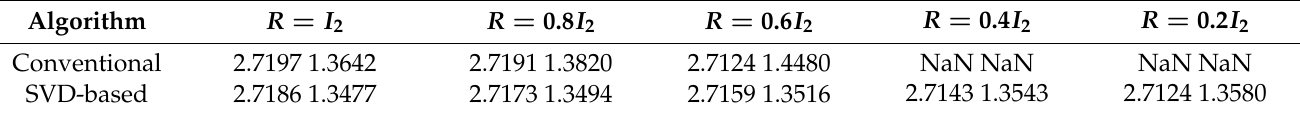
Table 9. Single precision C code: mean absolute errors ( φ , θ ) of estimated angles (degrees).